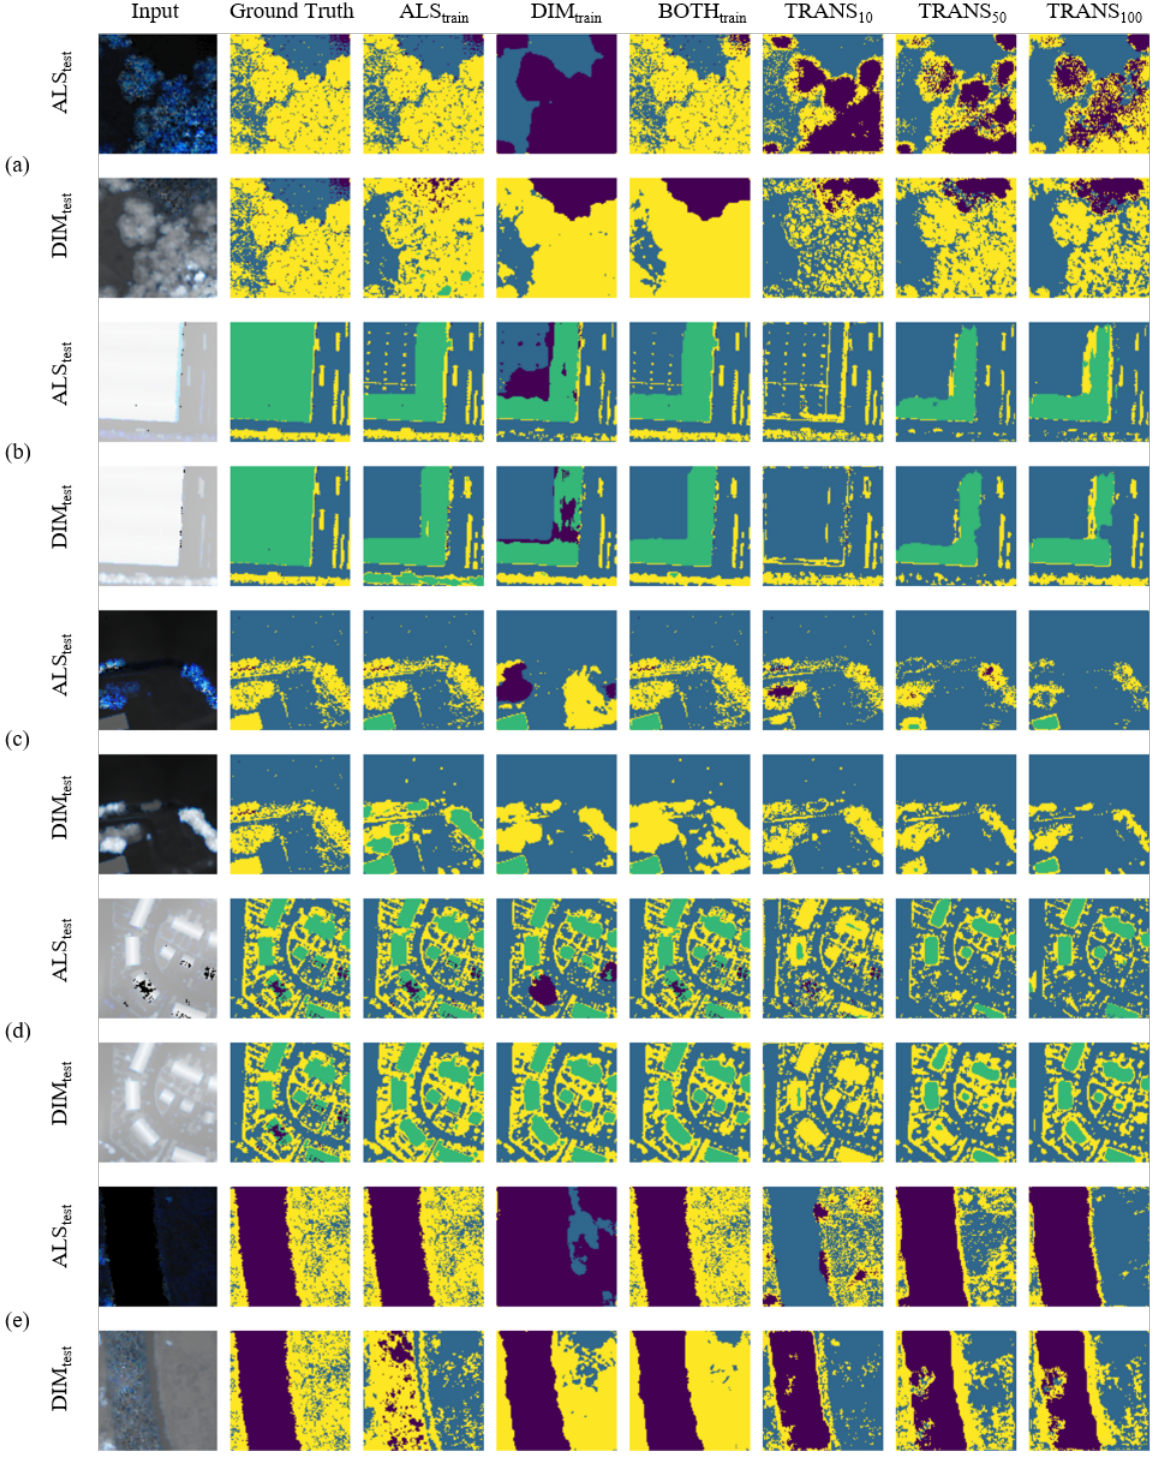
Figure 5. Qualitative results of our network setups. Each trained network is tested on ALS test and DIM test (rows). The input is rendered as normalized RGB image. The classes are no data (purple), ground (blue), building (green) and non-ground (yellow)